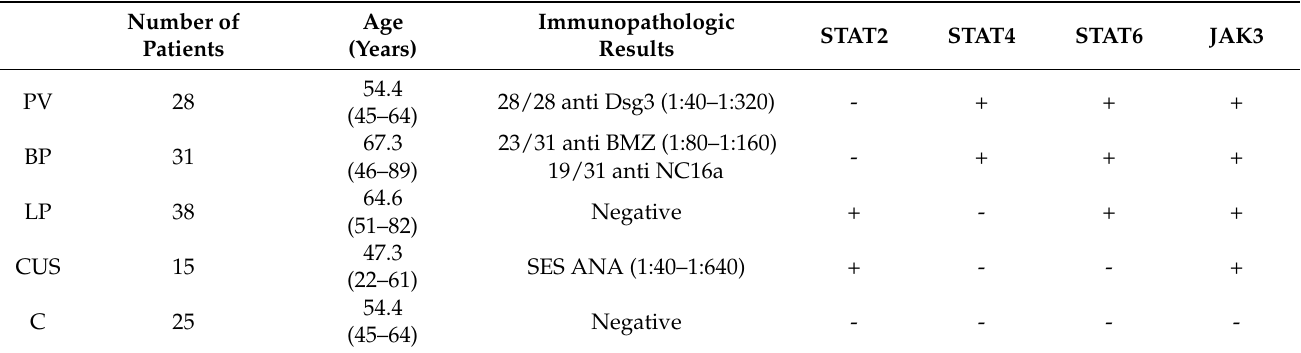
Table 5. Demographic data and immunohistopathologic findings (increased expression of se- lected protein vs. control group). PV—pemphigus vulgaris; BP—pemphigoid; LP—lichen planus; CUS—chronic ulcerative stomatitis; and C—control